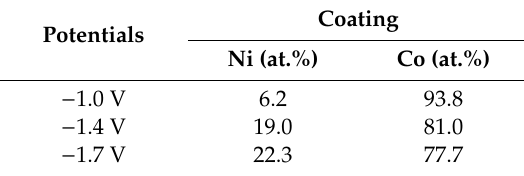
Figure 1. SEM images of ( a ) the bare carbon steel and the Co–Ni coatings under the applied potential of ( b ) − 1.0 V, ( c ) − 1.4 V, and ( d ) − 1.7 V for 3000 s in the mixed solution at room temperature. The insets show the corresponding cross section. Table 1. EDS results of the deposited Co–Ni coatings under different applied potentials for 3000 s in the mixed solution.